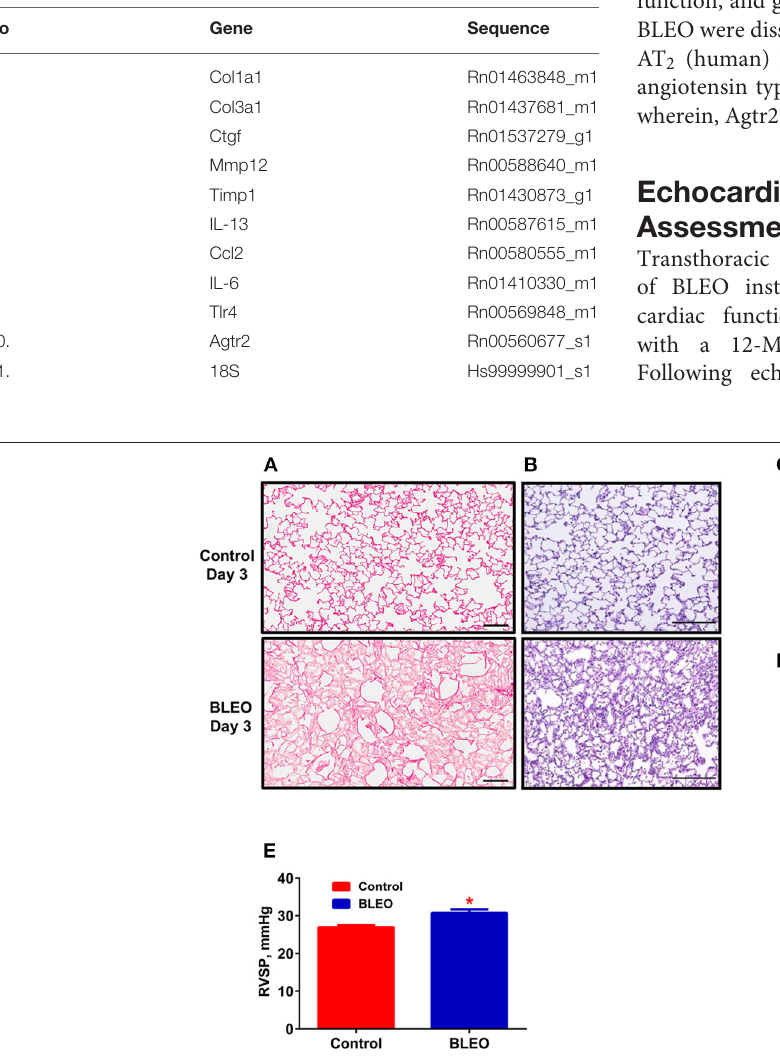
Frontiers in Physiology |